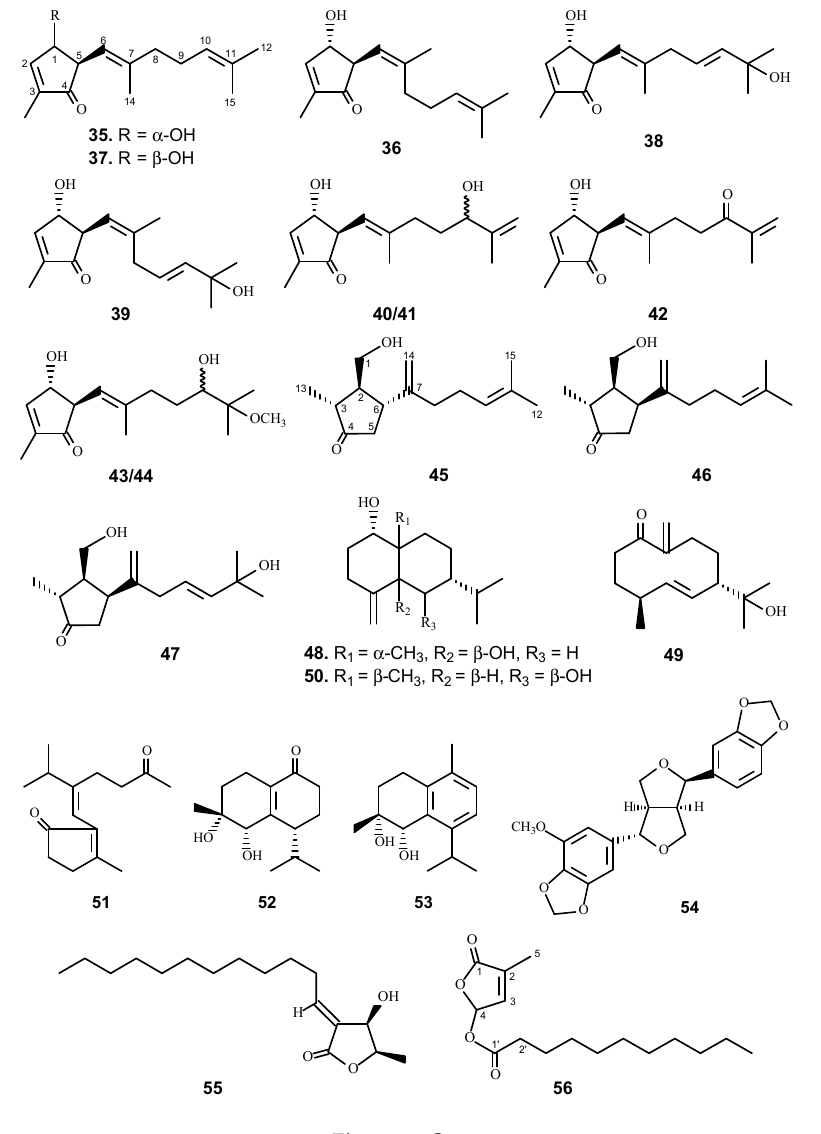
Figure 2. Cont. Figure 2.